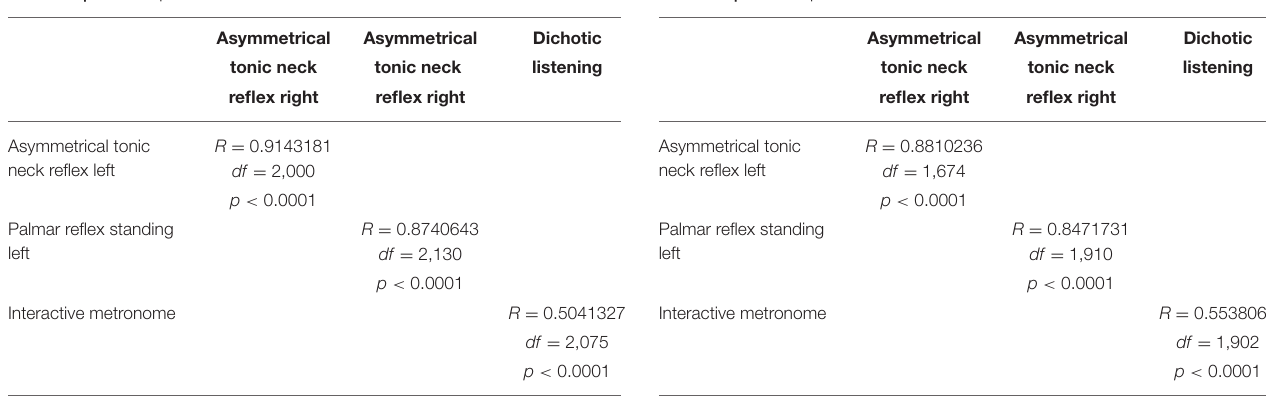
TABLE 2 | Pearson product-moment correlation— Pre-test. TABLE 3 | Pearson product-moment